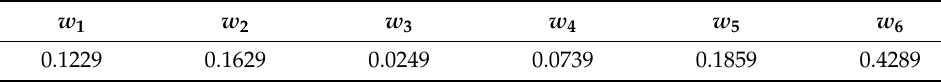
Table 6. Weights obtained by the statistical variation